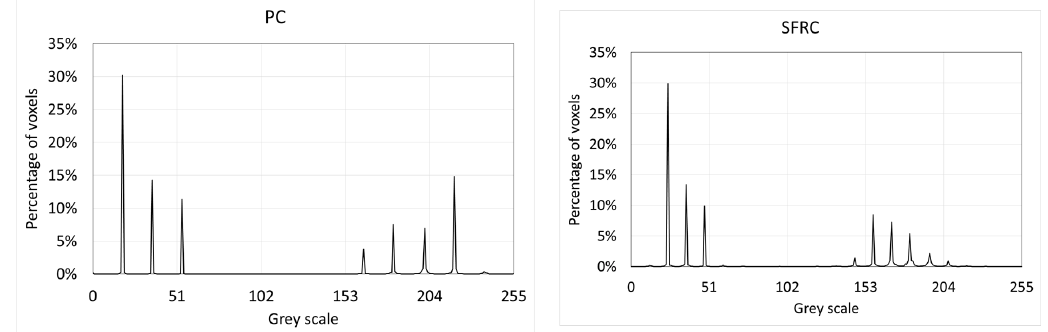
Figure 4. Histograms of grey scale.